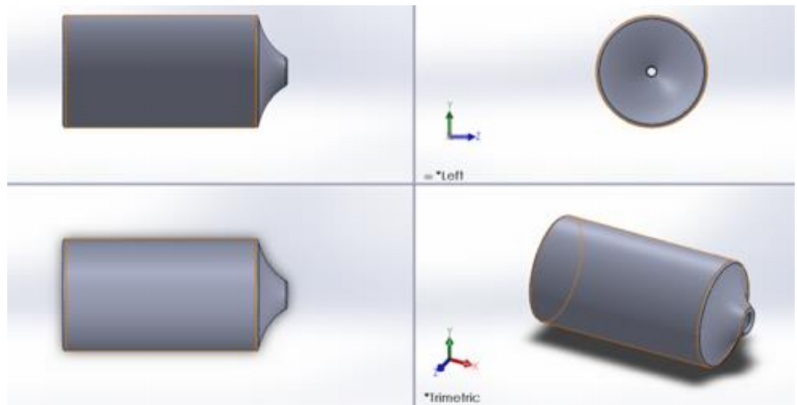
Figure 4. Wireframe model section with a close-up of the lymphatic vessel with a valve similar to the original to prevent the return of lymph (2019).